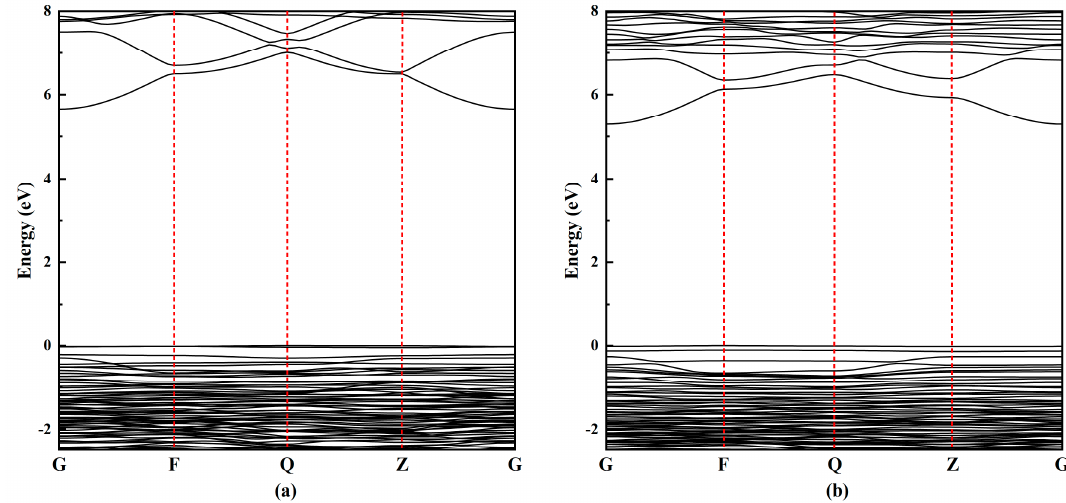
Figure 5. Band structure of the Na-MMT at 19.92 GPa ( a ) and Mg-MMT at 20.32 GPa ( b ) along high-symmetry points in the Brillouin zone under pressure. The Fermi energy was set at zero.